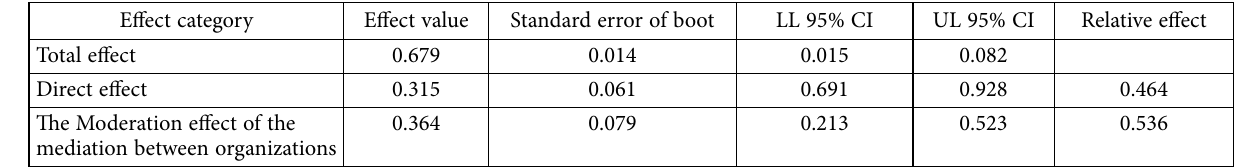
Table 3. Decomposition table of the total effect, direct effect, and mediation